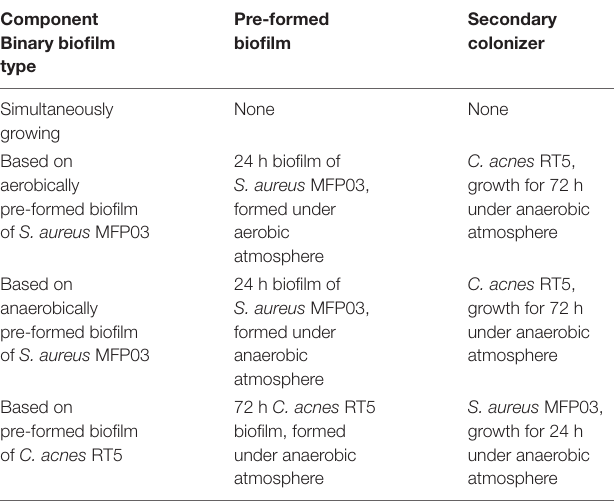
TABLE 2 | Types of binary biofilms of S. aureus MFP03 and C. acnes RT5 studied at 33 ◦